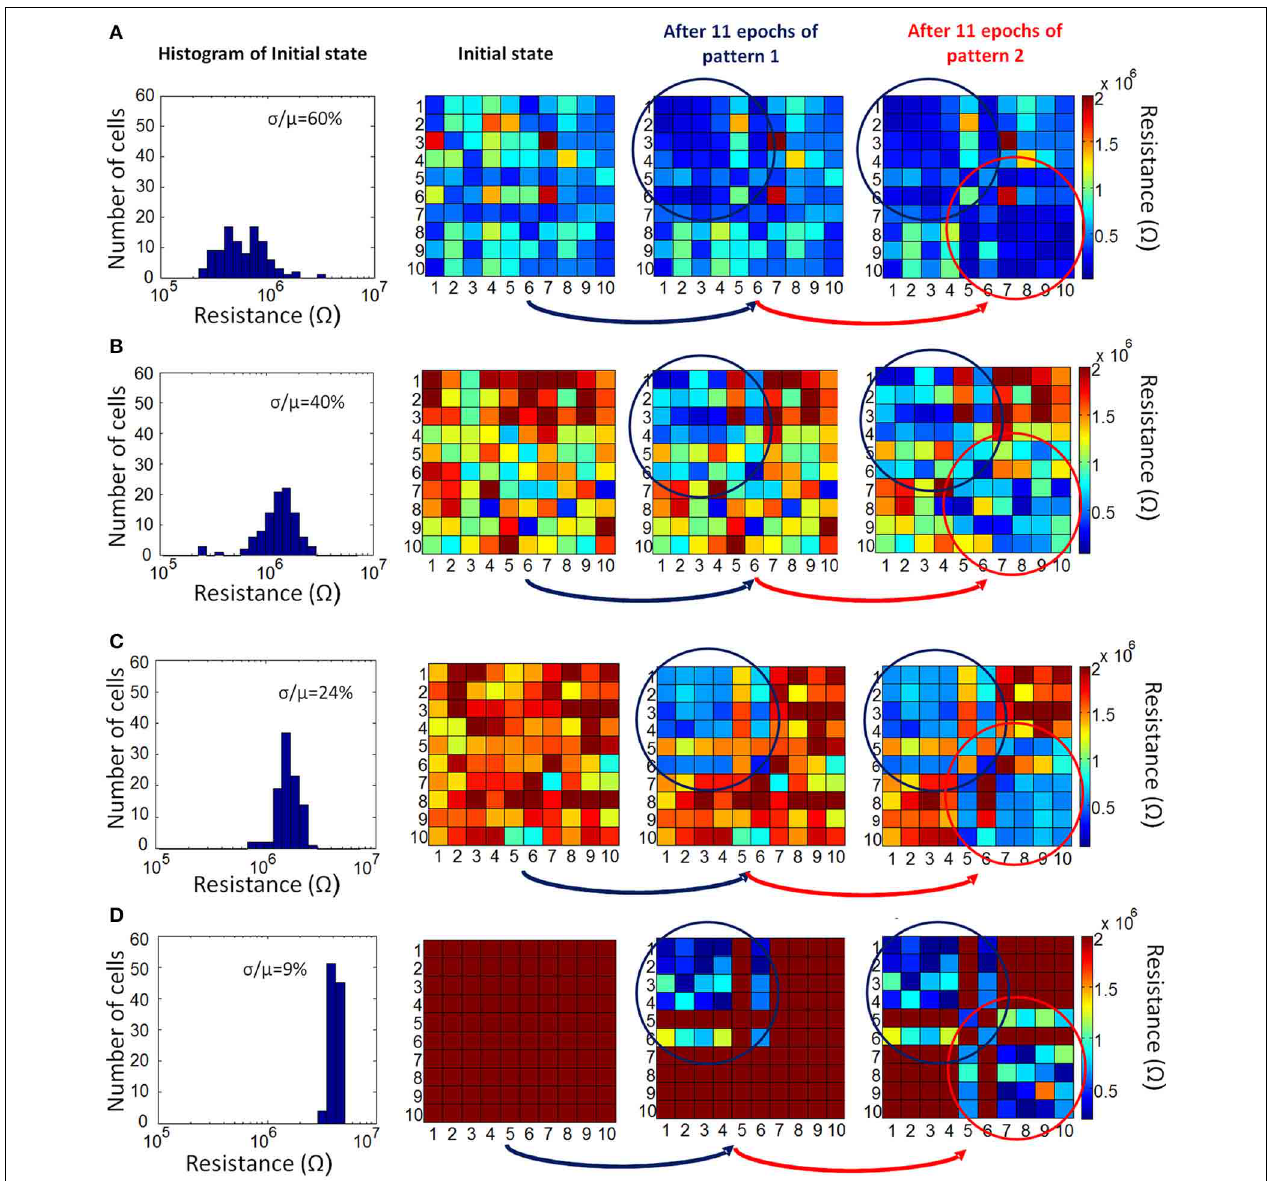
FIGURE 5 | Evolution of actual resistance of synaptic devices is shown for four different initial resistance variation cases: (A) 60%, (B) 40%, (C) 24% and (D) 9%. The representation of synaptic devices in these resistance maps are the same as in Figure 4 , but this time the resistance values are not normalized. The variations across the